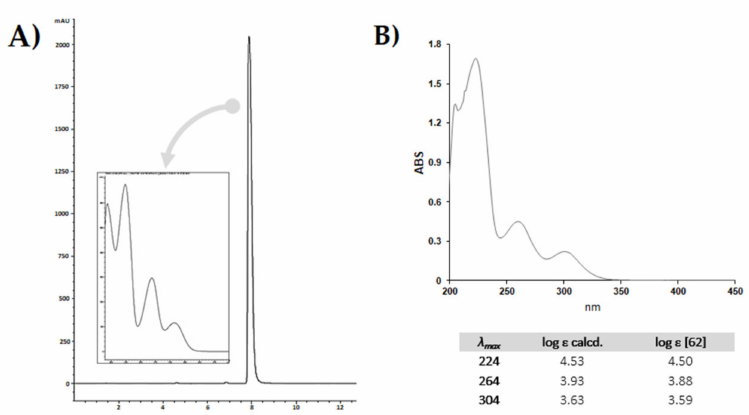
Figure 5. ( A ) HPLC-UV-DAD chromatographic profile of purified compound; UV-DAD spectrum is into the box. The RP-18 PLC-isolated compound (10 mg / mL, MeOH) was analysed by the HPLC 1260 INFINITY II system (Agilent, Santa Clara, CA, USA), equipped with an Agilent G7129A autosampler, an Agilent GY115A DAD-UV-visible detector, and a Quaternary pump Agilent G711A. The analysis was carried out using the Luna ® Phenyl-Hexyl column (150 × 2 mm, 3 µ m). The mobile phase consisted of a binary solution A: 0.1% HCOOH in H 2 O, B: 0.1% HCOOH in CH 3 CN. A linear gradient was started at 55% B, held for 1.5 min, and linearly ramping to 95% B in 6.50 min. The mobile phase composition was maintained at 95% B for another 2 min, then returned to the starting conditions and allowed to re-equilibrate for 3 min. The total analysis time was 13.00 min. The injection volume was 3.0 µ L; the flow was set at 0.3 mL / min. ( B ) UV-Vis spectrum of CBDA from hemp pollen, acquired in the range 190–450 nm using a UV-1700 double beam spectrophotometer (Shimadzu, Kyoto, Japan). The pure metabolite was solubilized in MeOH with a final concentration of 0.5 × 10 -5 M. The table below shows the calculated molar extinction coe ffi cients (log ε ). Literature values are reported for